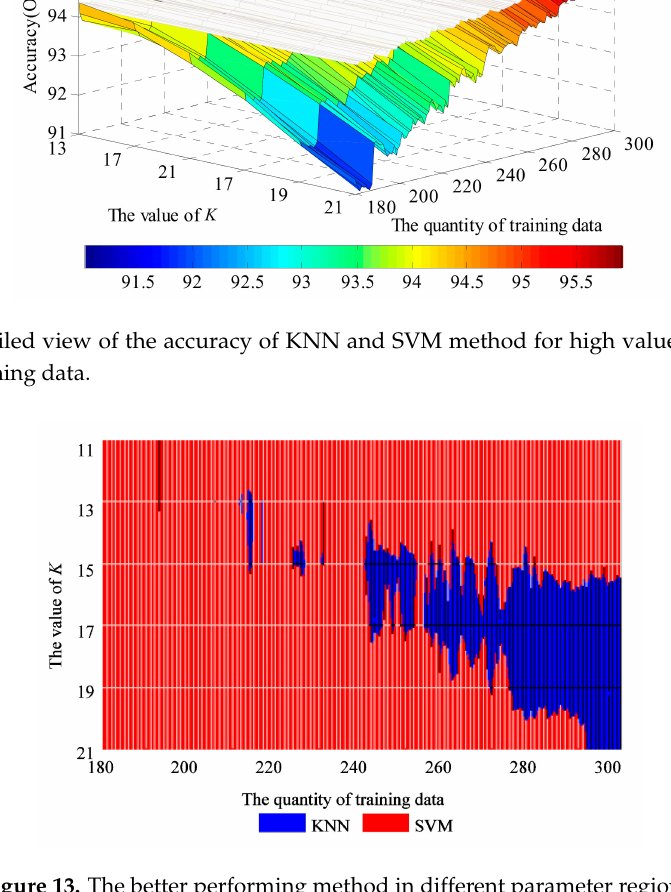
Figure 13. The better performing method in different parameter